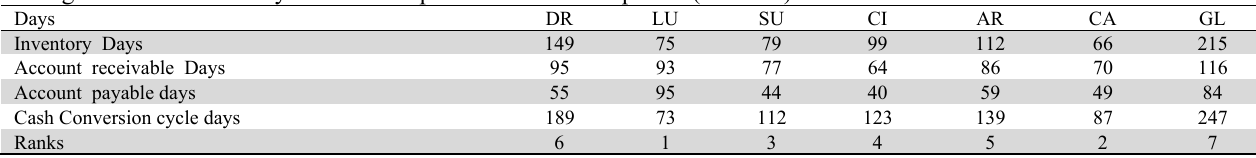
Source: Based on calculation of table 1, 2, and